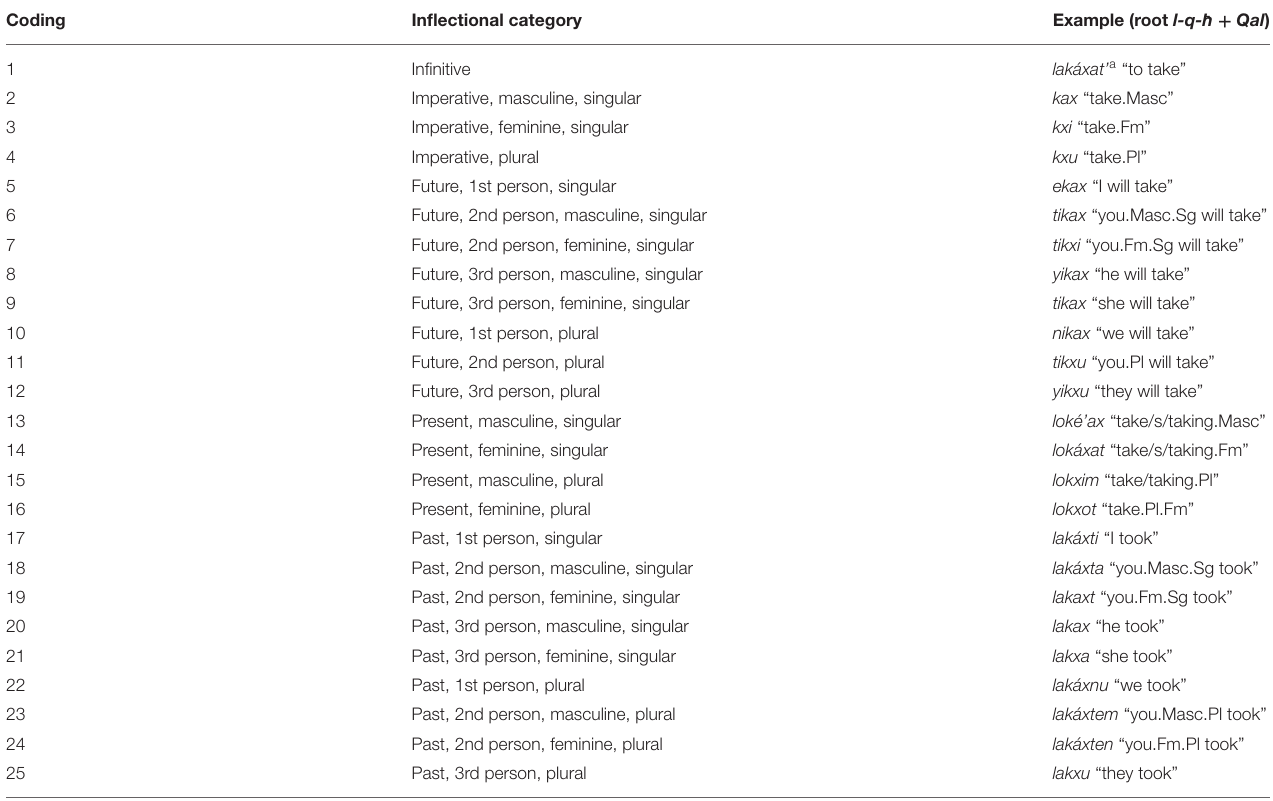
TABLE 3 | Hebrew verb inflectional categories.